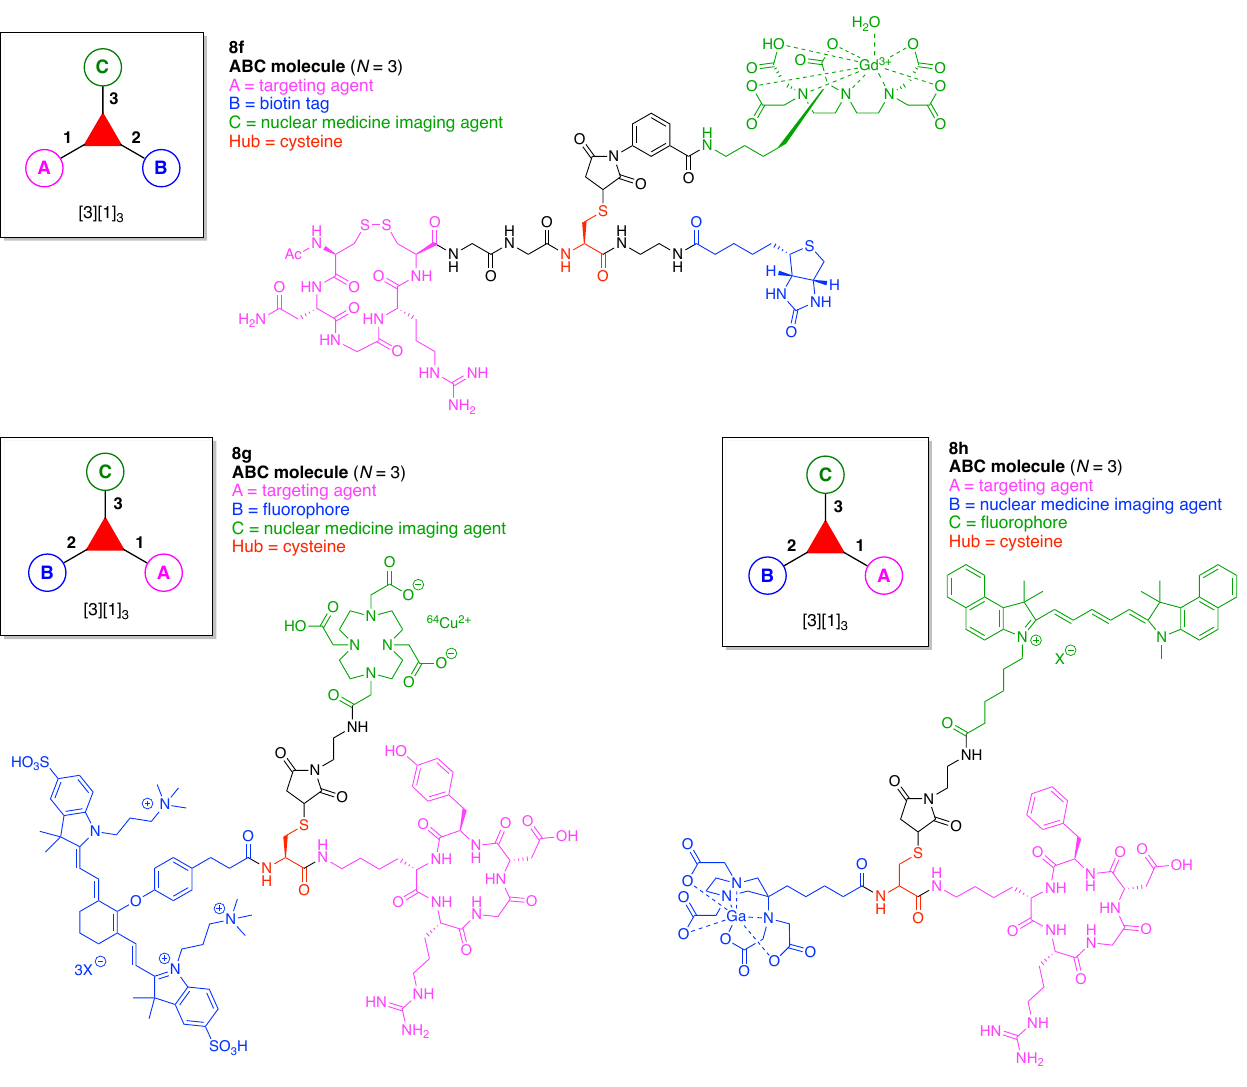
Figure 26. Three examples each with one cysteine hub.